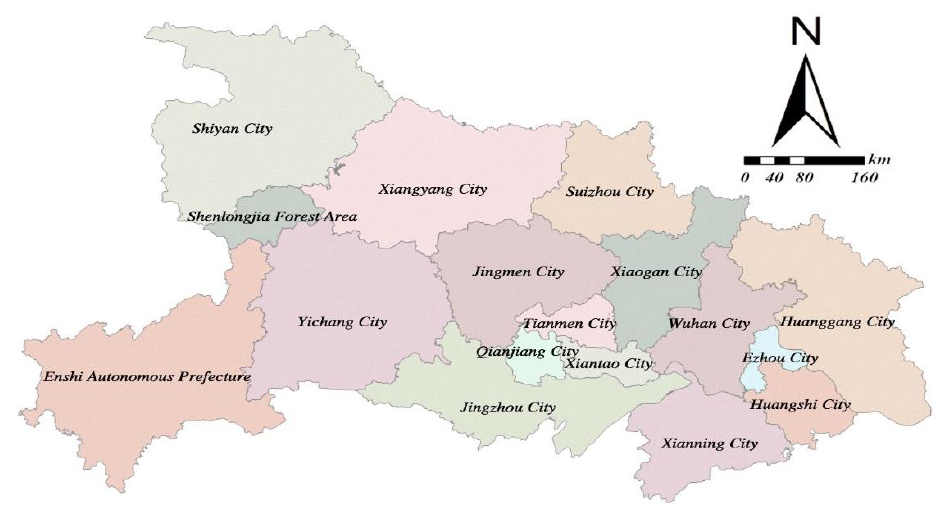
Figure 2. Map of Hubei Province. Note: the map was generated by ArcGIS 10.2.